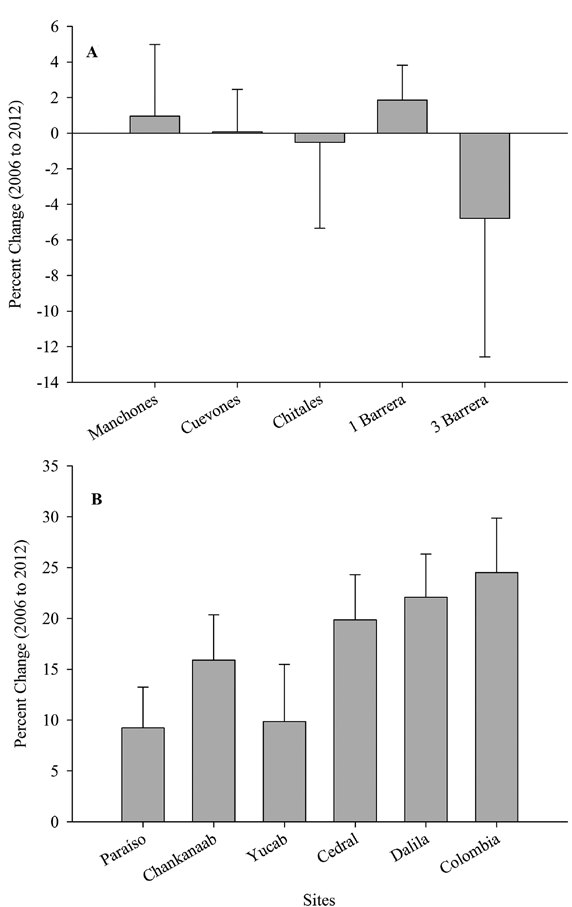
Fig. 3. – Coral cover percentage change from 2006 to 2012 (±SE) of the studied reefs at Cancún (A) and Cozumel (B).